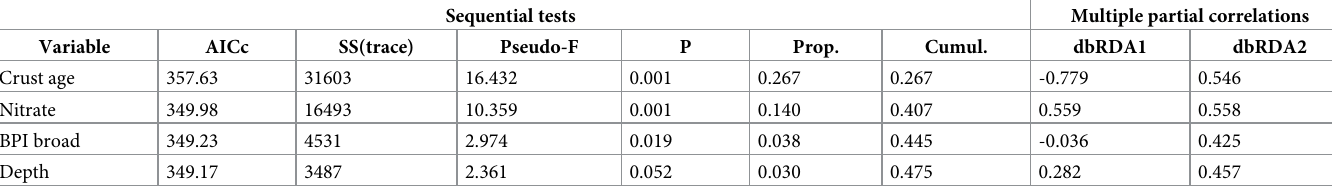
Table 1. Distance-based linear model for invertebrate assemblages and environmental variables.